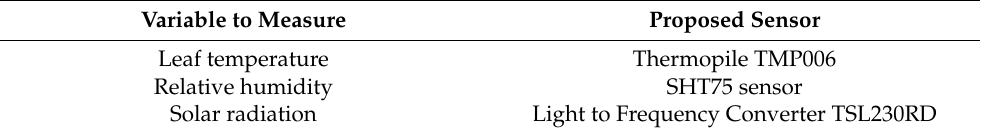
Table 3. Variables included in the mathematical models and the sensors proposed for their measure- ment